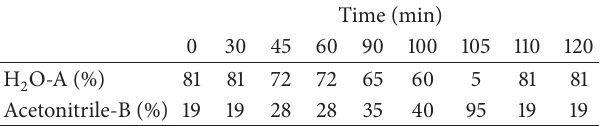
Table 2: The linear gradient program of nine kinds of ginsenosides. Table 3: The content ranges of ginsenosides from calibration and validation